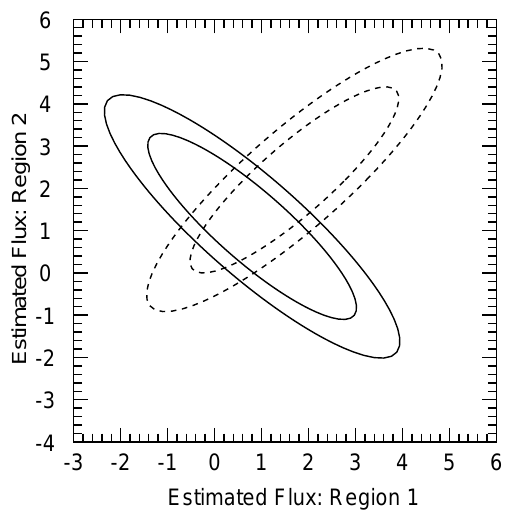
Fig. 1. Schematic of relation between top-down (solid ellipses) and bottom-up (dashed ellipses) estimates, for an idealised case with two flux